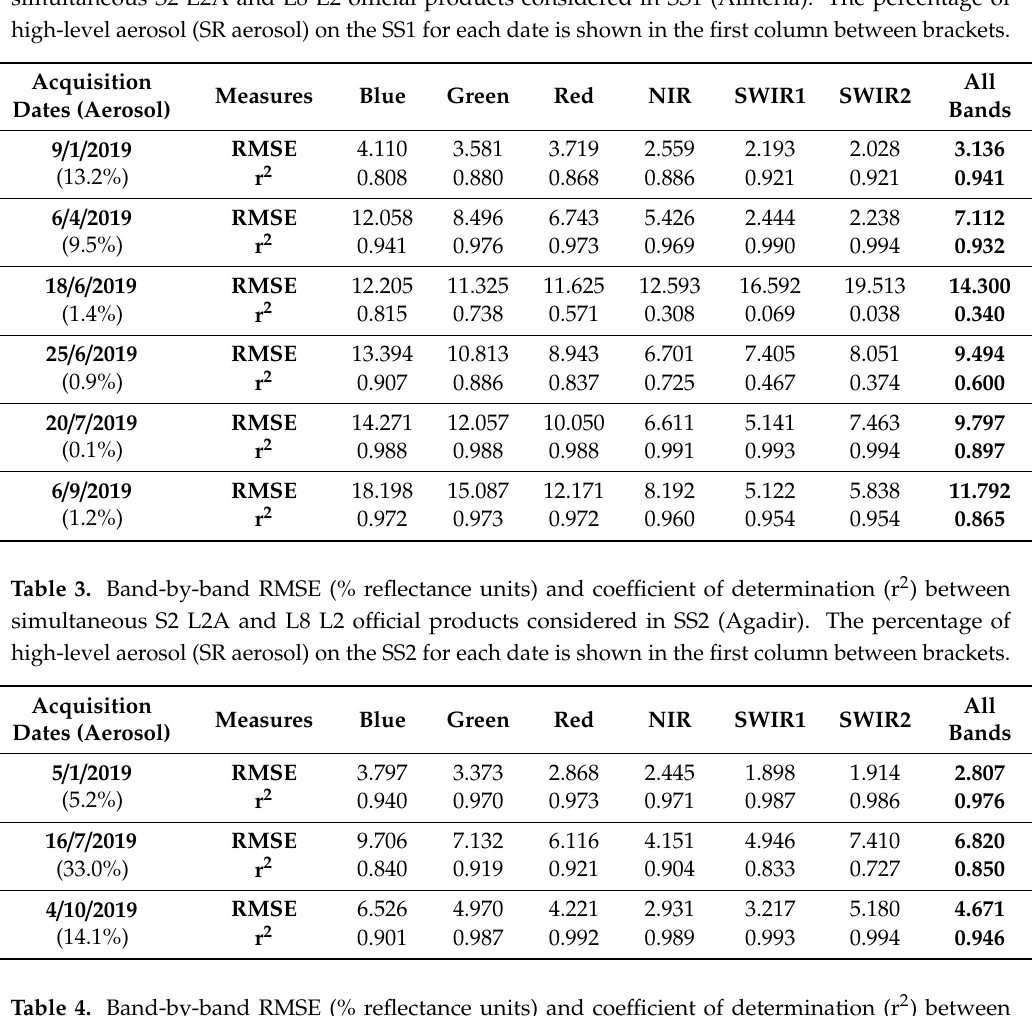
Table 4. Band-by-band RMSE (% reflectance units) and coe ffi cient of determination (r 2 ) between aerosol (SR aerosol) on the SS3 for each date is shown in the first column between brackets.